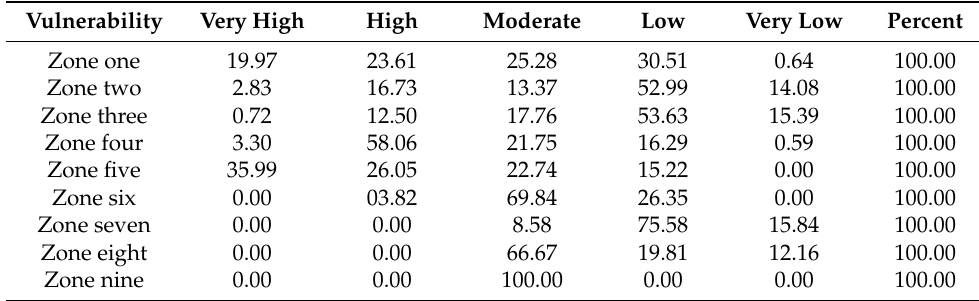
Table 9. Assessment of Population Vulnerability (PV) in Tabriz according to the MLP method. Vulnerability